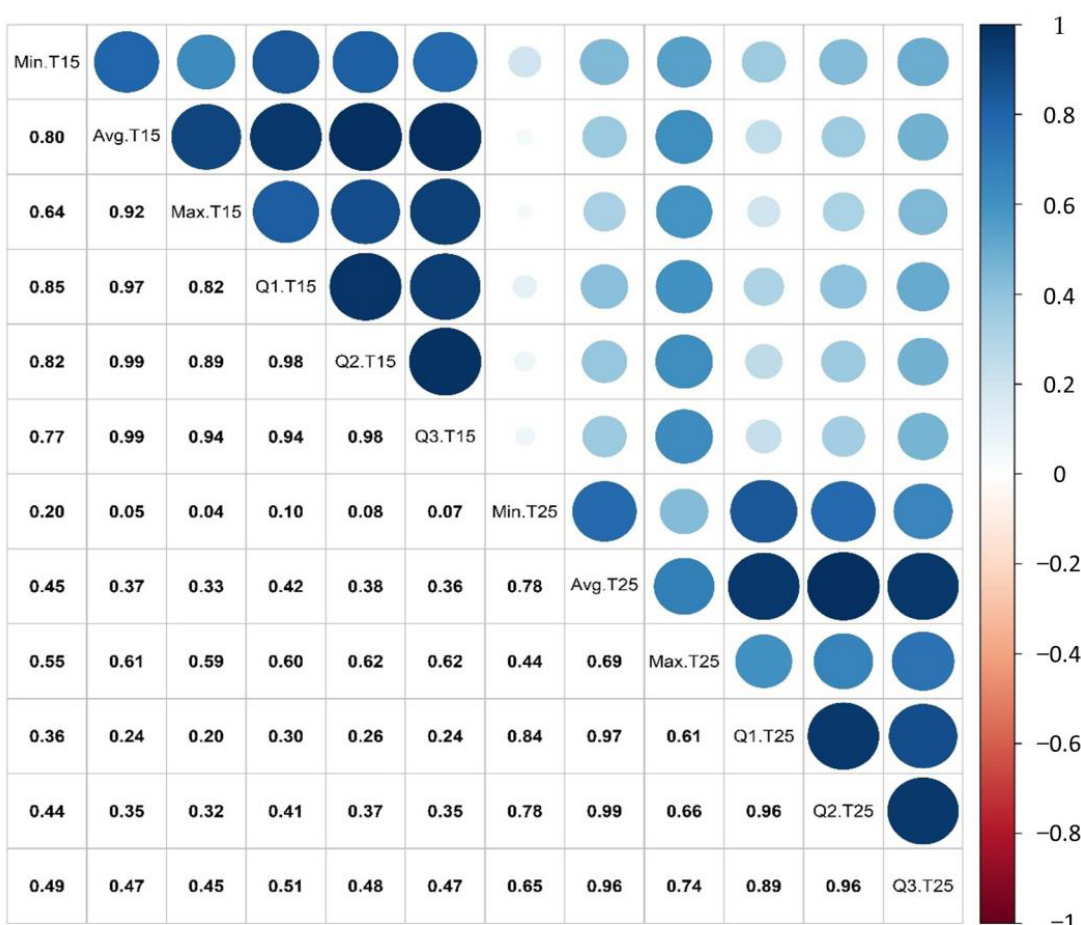
Figure 4. Spearman correlation coefficients between variables. Variables include the minimum (Min.), average (Avg.), maximum (Max.), first (Q1), second (Q2) and third quantile (Q3) of the pollen tube length measured at 15 ◦ C (T15) and 25 ◦ C (T25). Data were combined from 41 individuals. Color bar on the right represents the range of the correlation coefficient, ranging from − 1 (dark red, strong negative correlation) to 1 (dark blue, strong positive correlation).